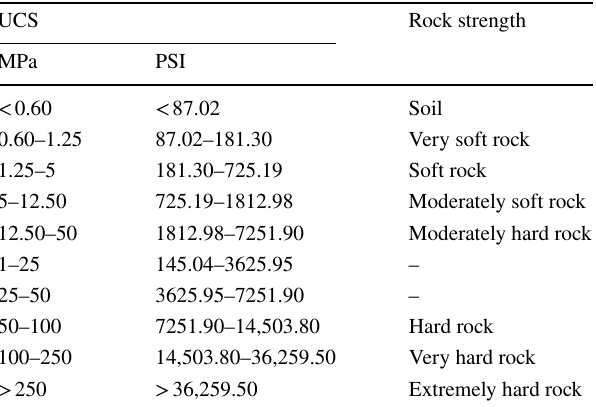
Table 2 UCS classifications. Source : National Engineering Hand- book